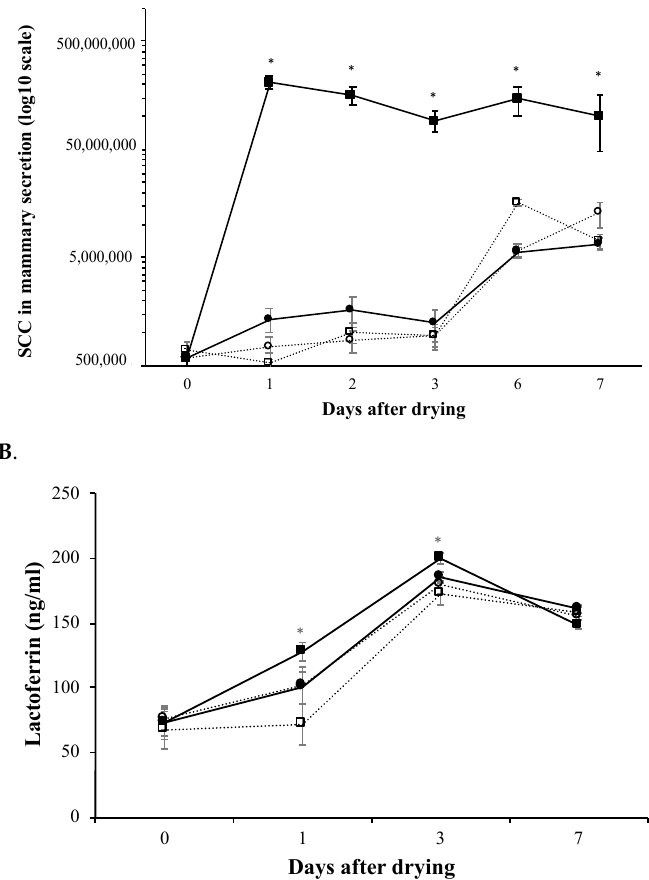
Figure 3. ( A ) Progression of somatic cell counts (SCC) in mammary secretion at 0, 1, 2, 3, 6 and 7 d after dry-off of pregnant dairy-cows. ( B ) Lactoferrin concentration in mammary secretion at 0, 1, 3, and 7 d after dry-off of pregnant dairy-cows. In all panels continuous lines depict rtMMP-9 treatments (IBs or soluble) and discontinuous lines indicate negative controls (saline). Circles correspond to soluble rtMMP-9 treatment and to the corresponding saline contralateral quarters whereas squares represent IBs of rtMMP-9 and their negative control in contralateral quarters. Asterisks indicate significant differences ( p < 0.05) between rtMMP-9 and negative controls. Lactoferrin concentration in mammary secretions increased ( p < 0.0001) over time after dry-off (Figure 3B). Lactoferrin concentration in mammary secretions from quarters treated with saline control or with the soluble form of rtMMP-9 did not differ at any sampling time during the week after dry-off. However, mammary secretion from quarters treated with positive controls had a greater ( p < 0.05) lactoferrin concentration than that from quarters with the negative control or treated with soluble rtMMP-9. There was also